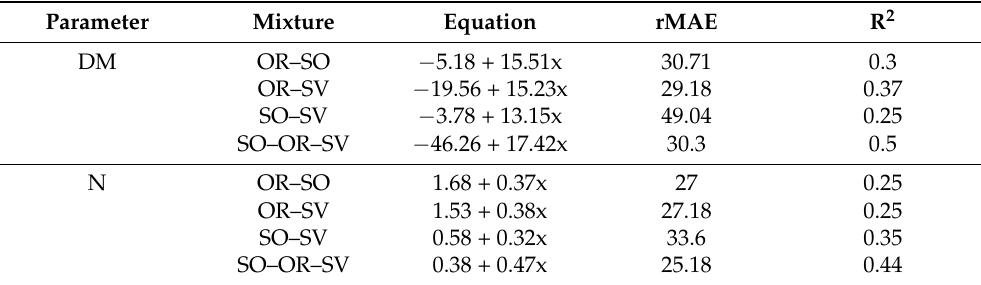
Figure 9. Comparison of the two model approaches’ prediction performance for dry matter (DM) and N uptake (N) by relative mean absolute error (rMAE) (%). Illustrated is the difference (Diff) of the universal model (uni) calibrated with the sole cover crop data set and mixture-individual models (mix) of each separate cover crop mixture (OR: oilseed radish, SO: saia oat, SV: spring vetch). Table 6. Mixture–individual models based on SR red for predicting the canopy parameters (dry matter (DM) (g m − 2 ) and N uptake (N) (g m − 2 )) of cover crop mixtures (OR: oilseed radish, SO: saia oat, SV: spring vetch). Model performance was assessed using the relative mean absolute error (rMAE) (%) and R². Calibration formula is noted for each mixture and each canopy parameter.